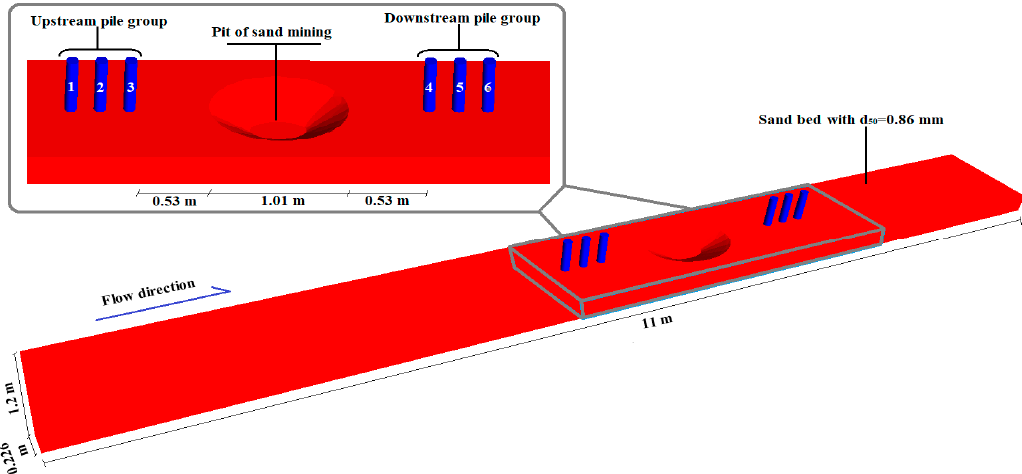
Figure 2. Simulated laboratory flume.